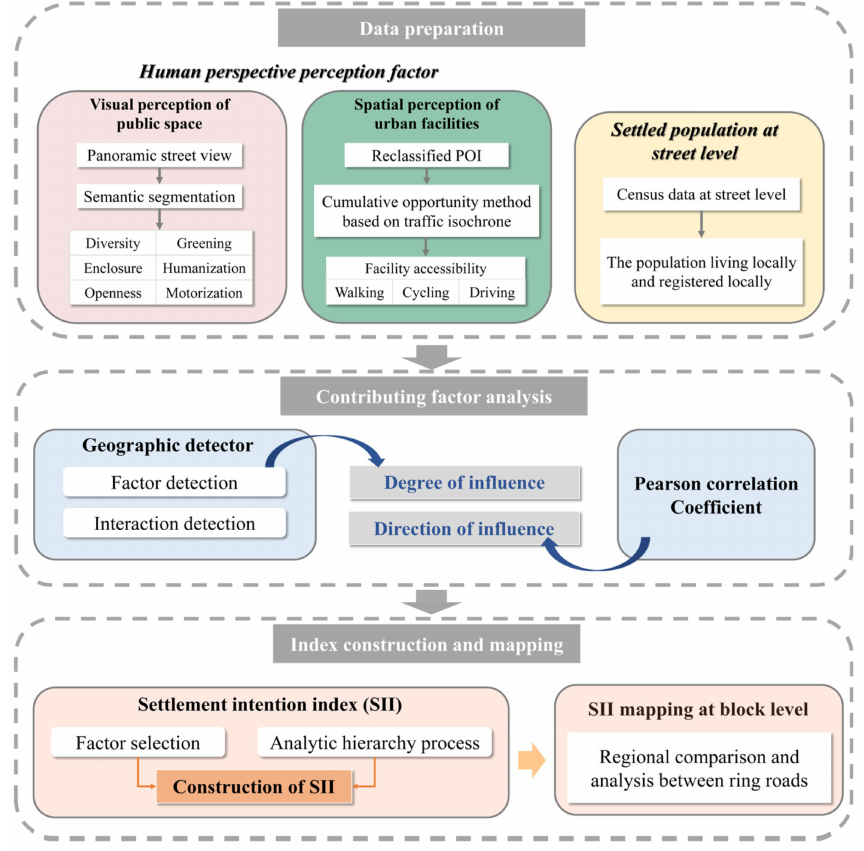
Figure 1. Flowchart of this